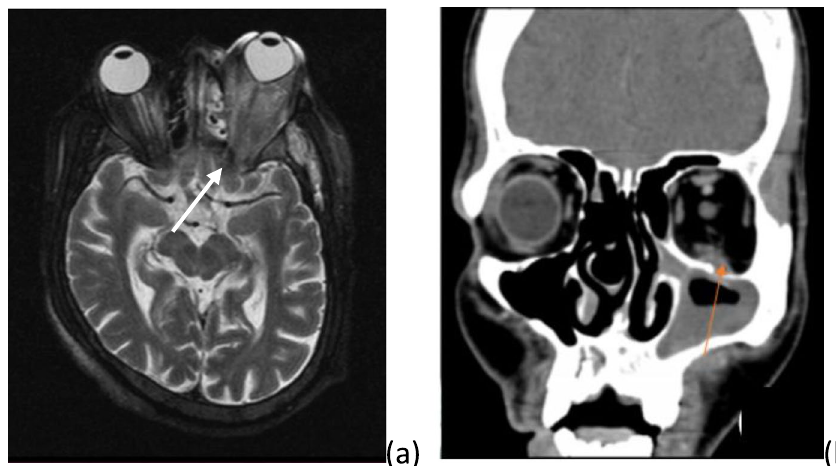
Fig. 5 a , b Radiographic pictures of case series 3. a Thickened superior ophthalmic vein with possible cavernous sinus thrombosis on MRI. b CT image showing opacities in (L) maxillary sinus extending into (L) orbit through a breach in the orbital